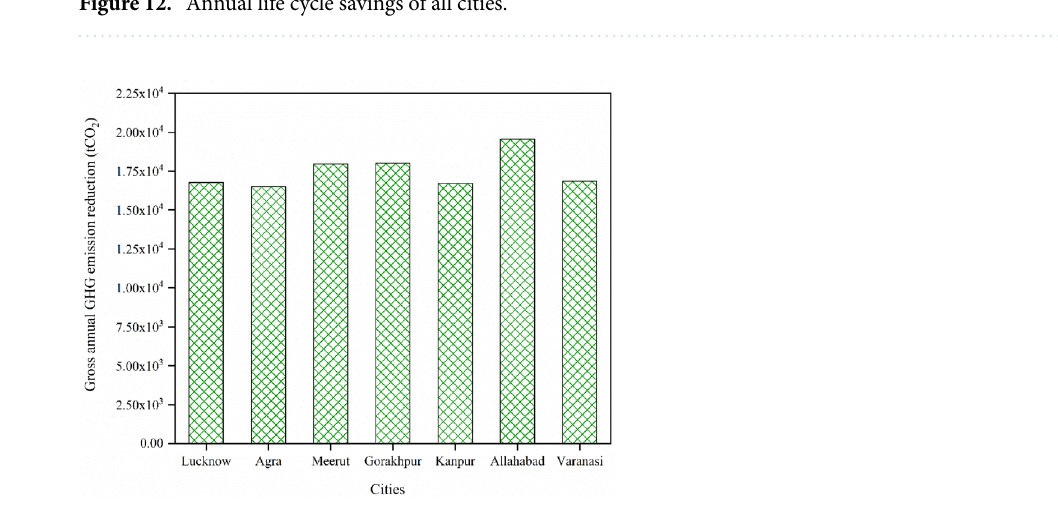
Figure 12. Annual life cycle savings of all cities.